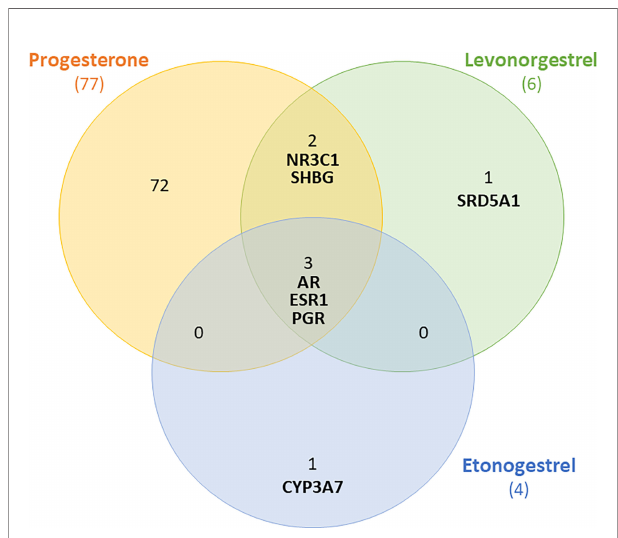
FIGURE 1 | Venn diagram showing receptors to which levonorgestrel, etonogestrel and progesterone can bind with high af fi nity. Shared receptors include androgen (AR), estrogen-1(ESR1) and progesterone receptors (PGR).